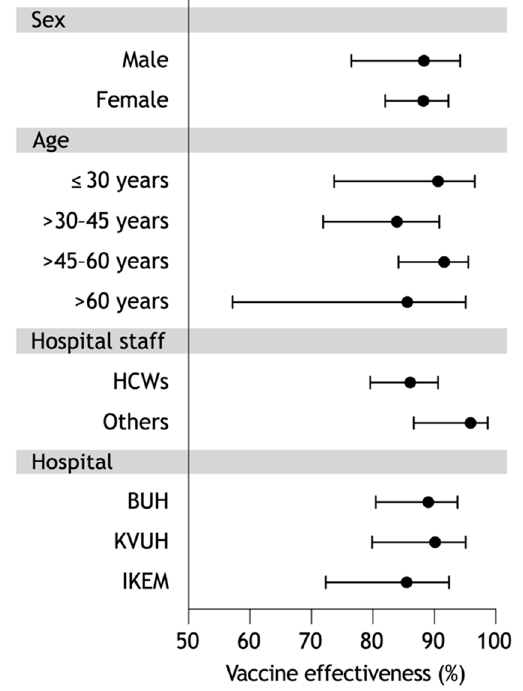
Figure 3. Vaccine effectiveness in specific PU group within 8-month follow-up: HCWs: health-care workers; BUH: Bulovka University Hospital; KVUH: Kr á lovsk é Vinohrady University Hospital; IKEM: Institute for Clinical and Experimental Medicine.